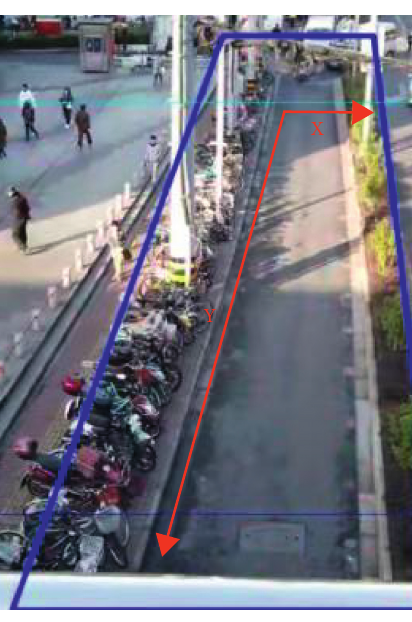
Figure 5: Shooting view.